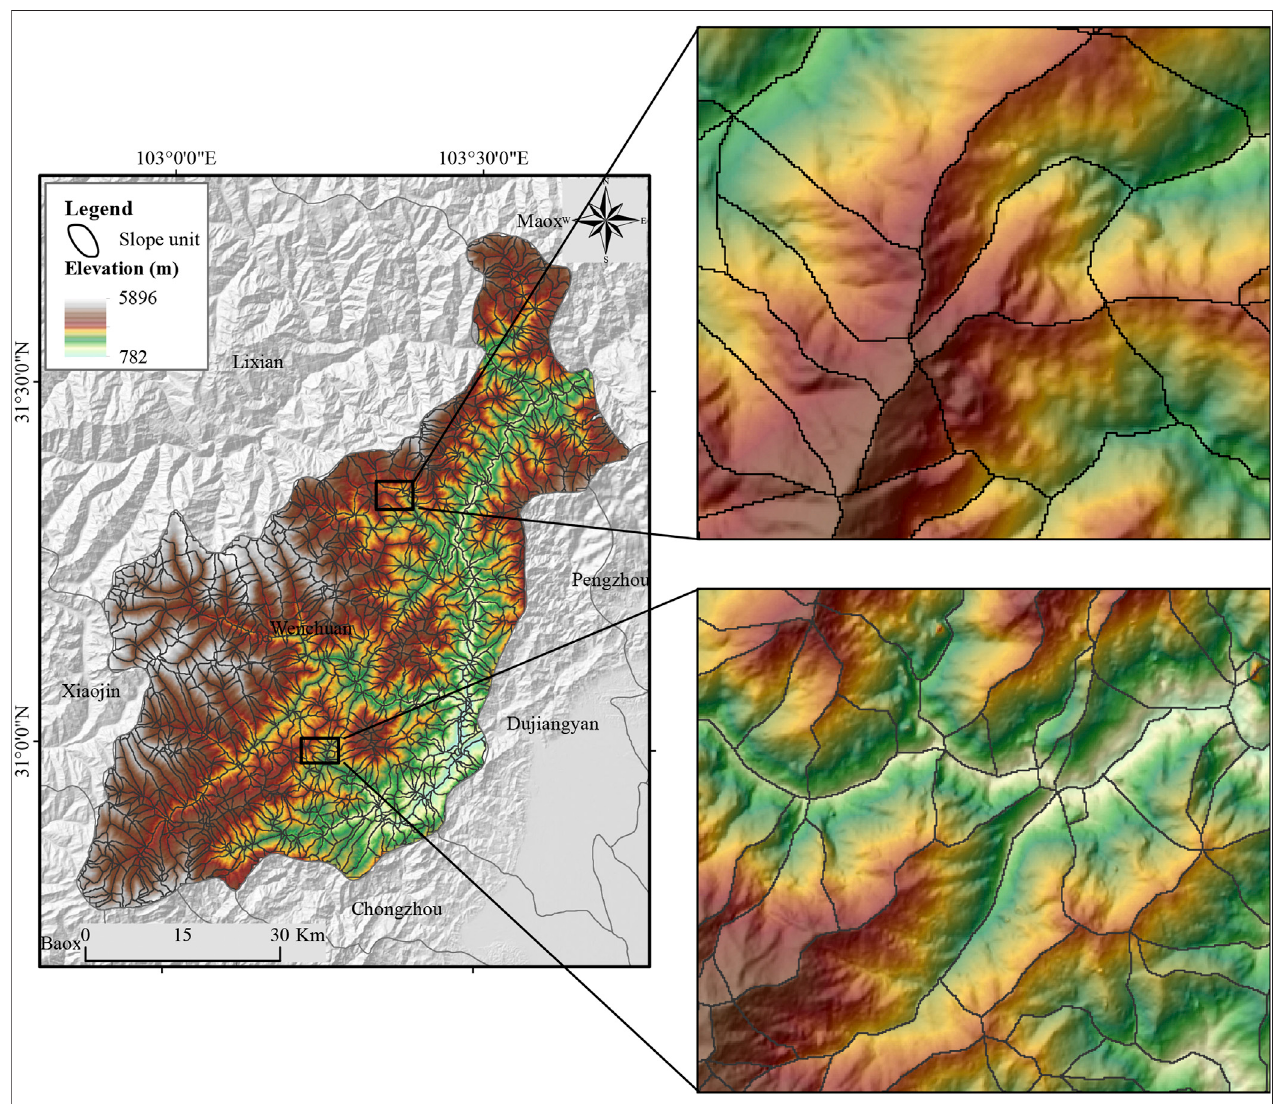
FIGURE 4 | Slope units of the study